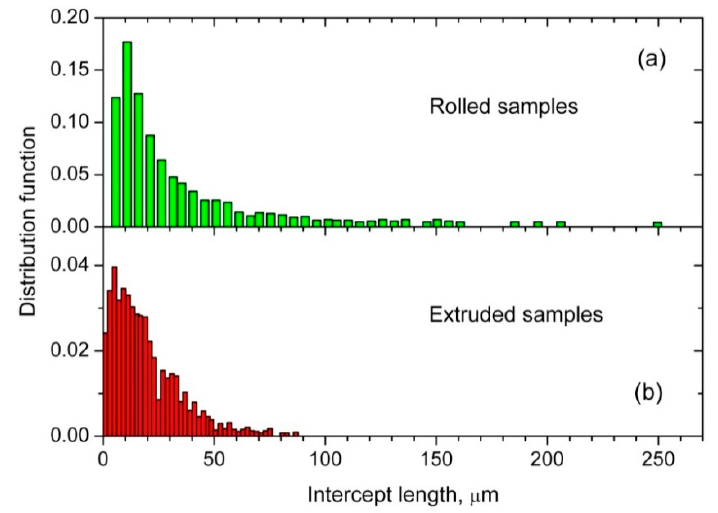
Figure 3. Distribution of grain sizes in ( a ) rolled and ( b ) extruded samples.